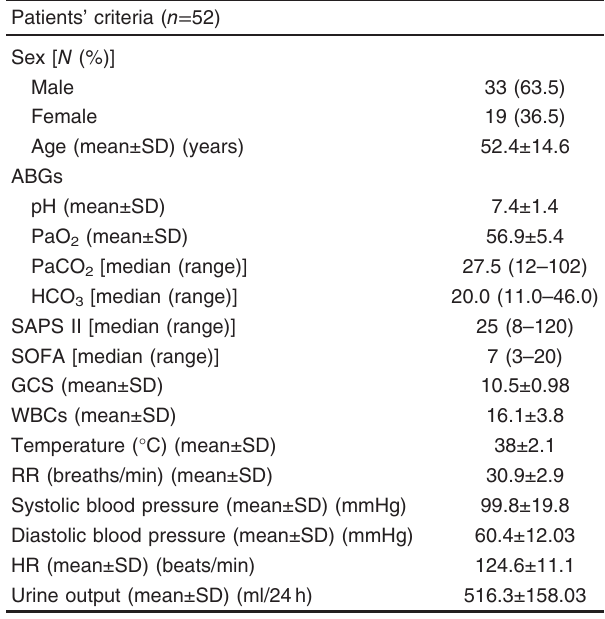
Table 1 Characteristics of the studied patients Patients ’ criteria ( n = 52)